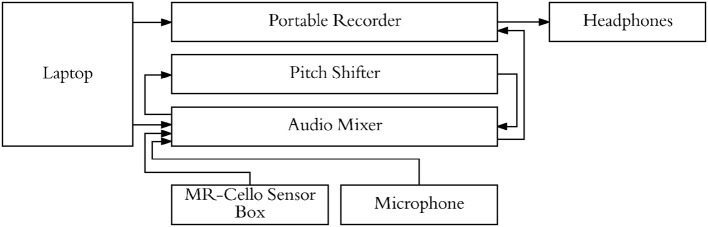
Experimental setup used to present stimuli, cello audio, and singing audio through headphones. Pitch shifter allowed for audio feedback from cello/singing to be blocked on specific trials while still presenting audio stimuli.